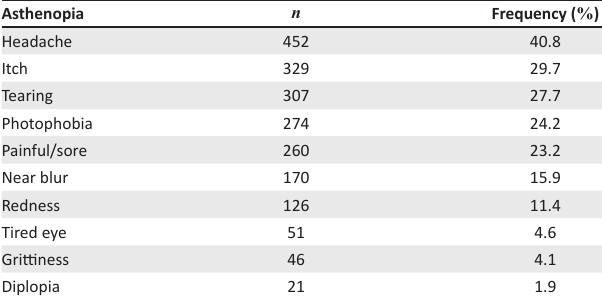
TABLE 2: Frequency of asthenopia.